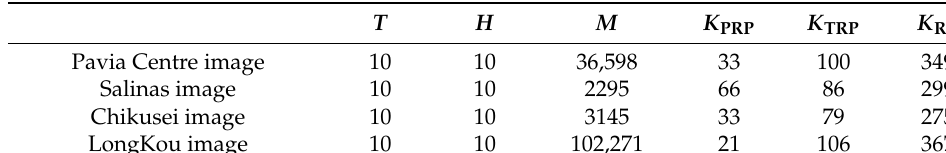
Table 2. Projection parameter settings in the experiment.